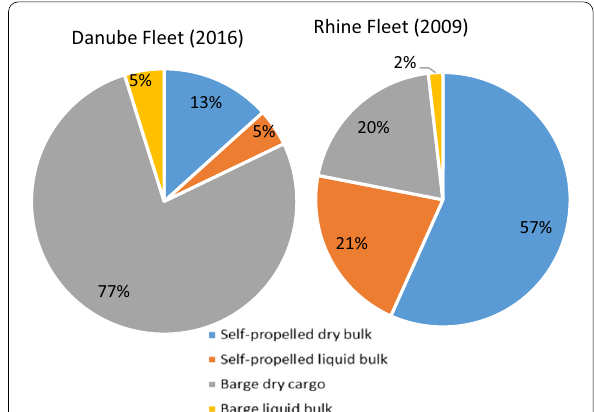
Fig. 3 Fleet composition of self-propelled vessels and barges. Source : (1) Danube fleet : Danube Commission, 2017. (2) Rhine fleet: